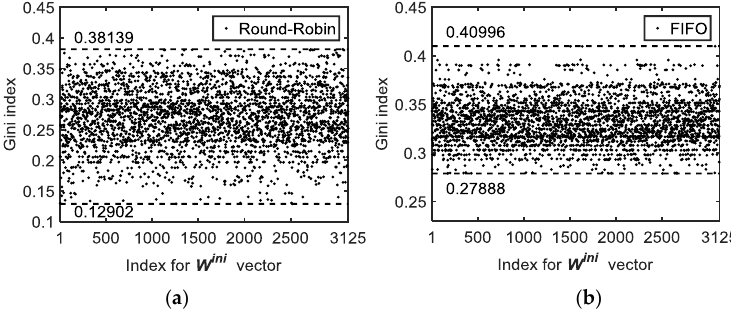
Figure 12. Gini index ( G ) for average end-to-end delay for two service policies: ( a ) Round-Robin and ( b ) FIFO. The bounds are shown in both graphs. Case data: N =6 nodes, simulation time: 1000 slots. Table 5. Bounds for delay Gini index (optimal scheduling). Simulation time: 1000 time slots. FIFO Round-Robin